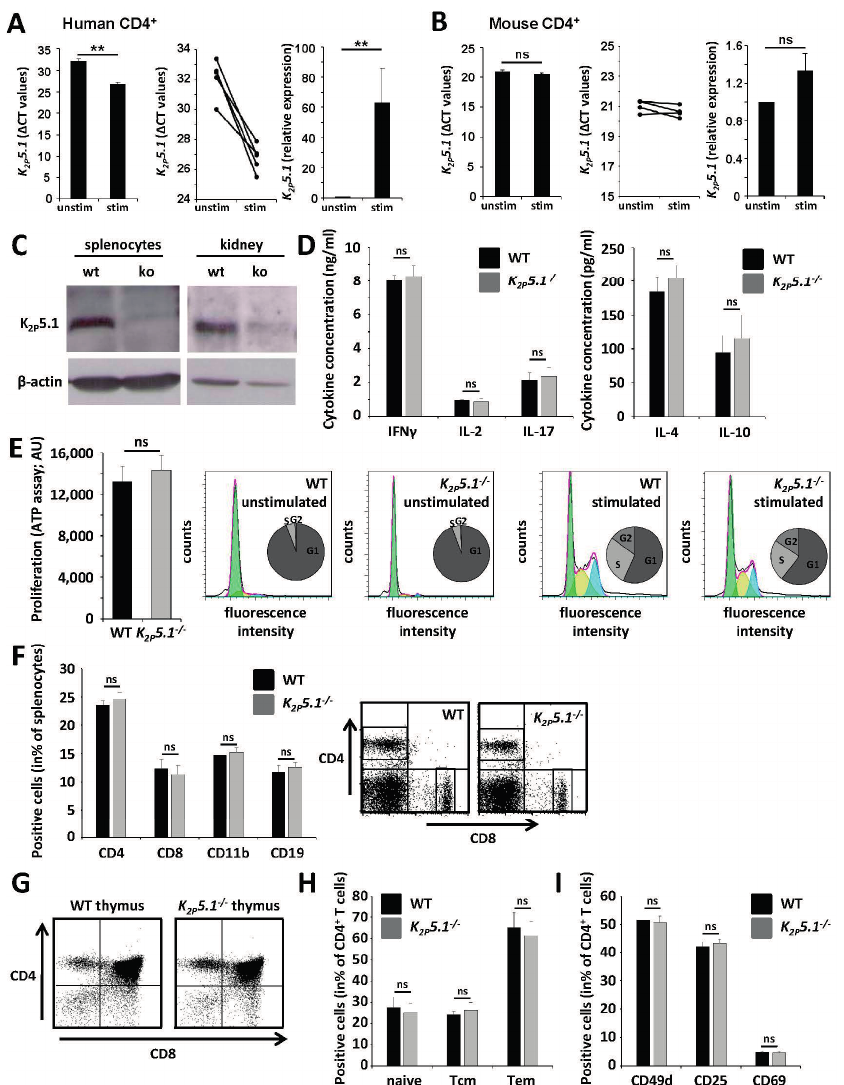
Figure 2. T lymphocytes from K 2P 5.1 − / − mice displayed no obvious differences in immune cell function ( A , B ). ( A ) Human, but not ( B ) mouse CD4 + T lymphocytes show an upregulation of K 2P 5.1 (left panel: mean Δ C t values; middle panel: all donors are displayed separately; right panel: relative expression); ( C ) K 2P 5.1 expression can be detected by Western blotting in splenocytes and kidney tissue from wild-type, but not from K 2P 5.1 − / − (ko) mice (representative examples); ( D ) WT and K 2P 5.1 − / − splenocytes show no differences in cytokine production ( n = 6); ( E ) No significant differences were observed for proliferation rates from WT and K 2P 5.1 − / − T lymphocytes ( left panel: proliferation assay; right panel: flow cytometry-based assessment of cell cycle stages; n = 8); ( F ) Splenocytes from WT and K 2P 5.1 − / − display a comparable immune cell composition ( n = 6); ( G ) WT and K 2P 5.1 − / − thymi are comparable concerning proportions of double-negative, double-positive and CD4 + /CD8 + single-positive cells ( n = 4, one representative example is shown); ( H , I ) CD4 + T lymphocytes from WT and K 2P 5.1 − / − mice show no significant alterations concerning ( H ) memory cell composition ( I ) and activation and migration markers ( n = 5). ns = not significant; ** p <